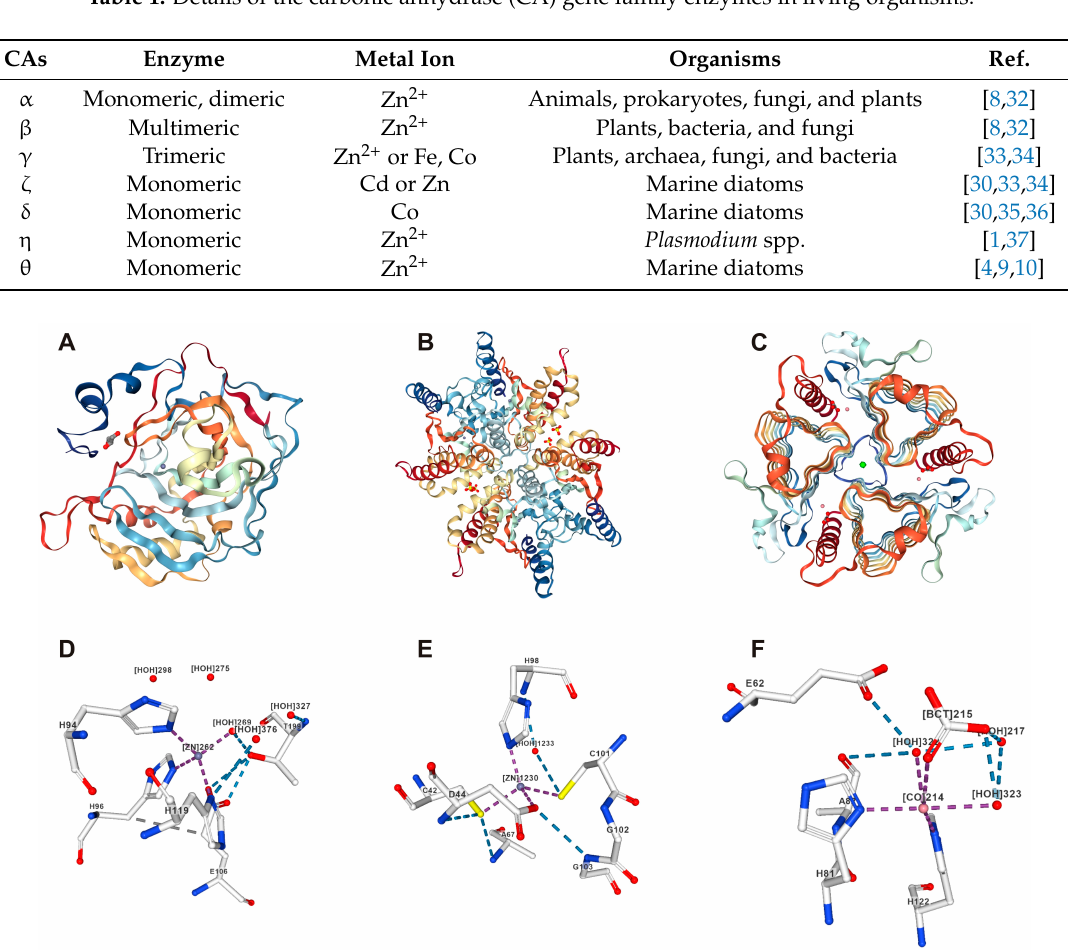
Figure 1. Representative structures of the α -CA, β -CA, and γ -CA families of enzymes and their ligand-binding sites. ( A ) Structure of human CAII enzymes retrieved from PDB 3U45. The human CAII monomer mostly consists of beta strands and contains a single active site with three zinc-coordinating histidine residues [38,39]; ( B ) Structure of Haemophilus influenzae β -CA retrieved from PDB 2A8C [40]; ( C ) Structure of γ -CA from Methanosarcina thermophila 1QRE [41,42]; ( D – F ) Metal at the active site coordinated with histidine residues (purple), hydrogen bonds (blue), halogen bonds (turquoise), hydrophobic contacts (gray), and pi interactions (orange, green). Images D and E show Zn 2+ at the active site, and image F shows the Co 2+ substitution in the structure.